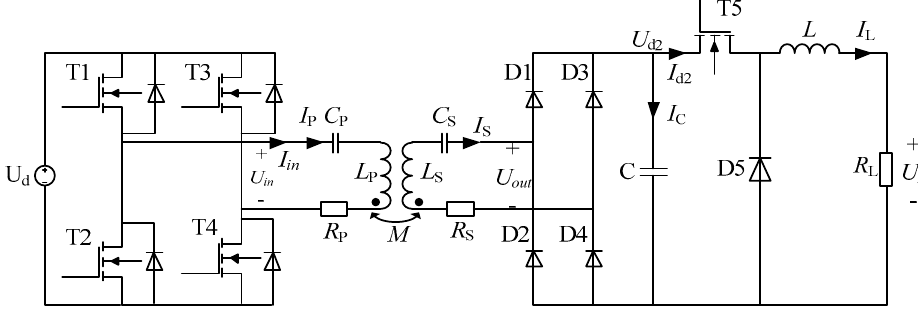
Figure 2. Series–series (SS) compensation cascade buck circuit mode.